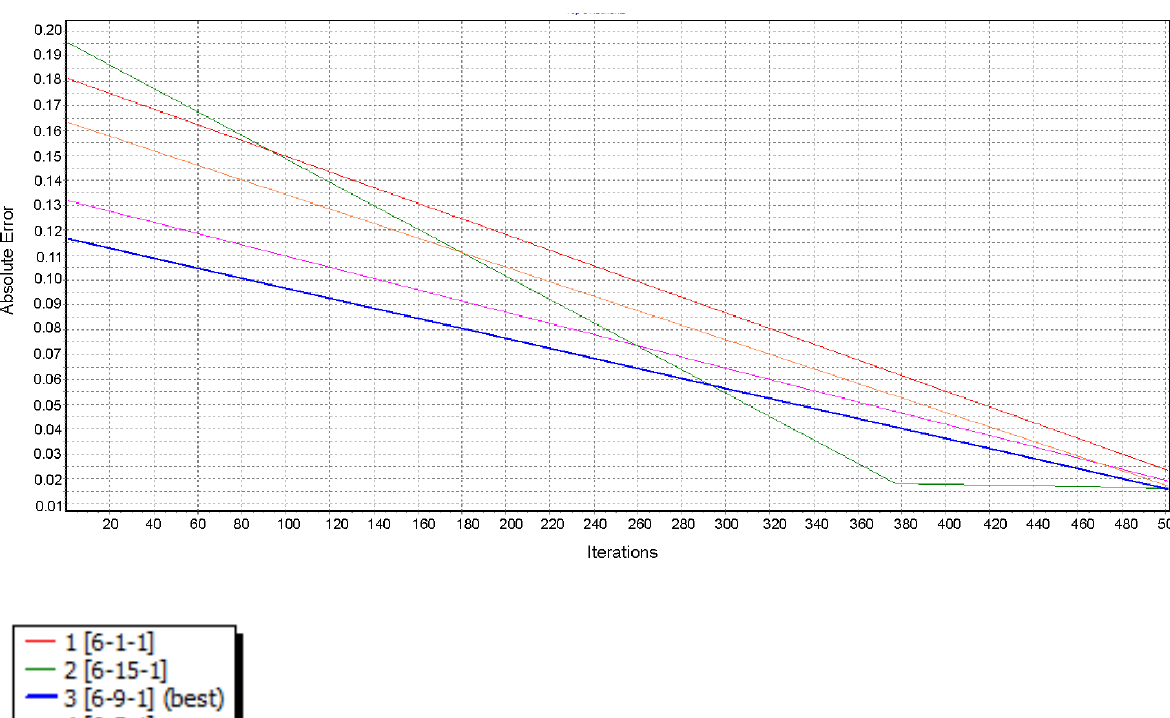
Fig. 5. Absolute ANN error versus No of iterations for different number of neurons in the hidden layer.